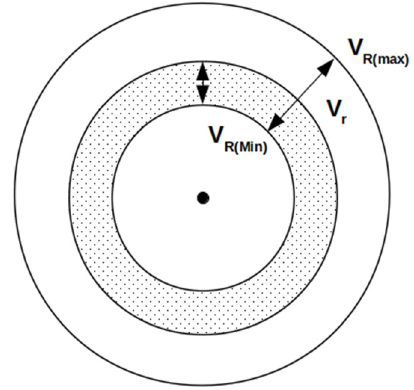
Figure 4. Cumulative function of the relative velocity—the ratio between the covered area and the area confined between v (min) and v (max) .